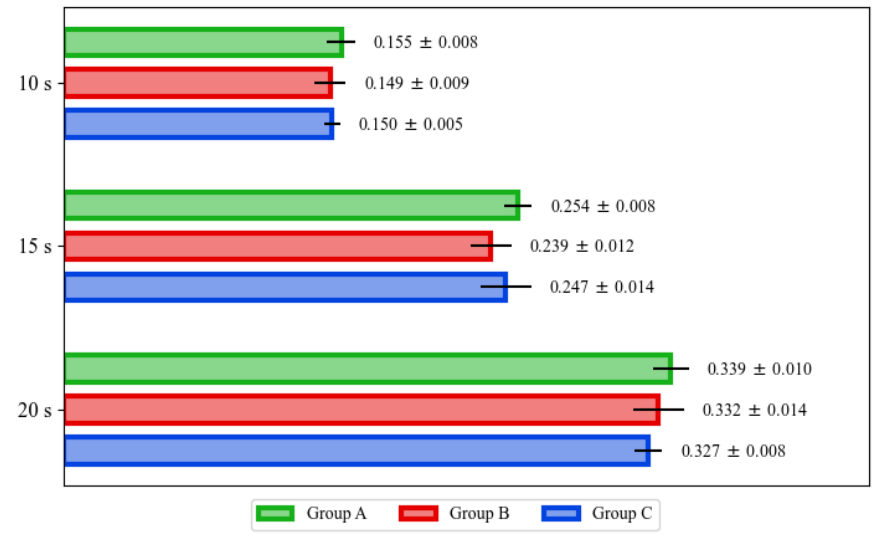
Figure 7. MAEs for LSTM DNN trained on data groups A, B, and C for 10, 15, and 20 s